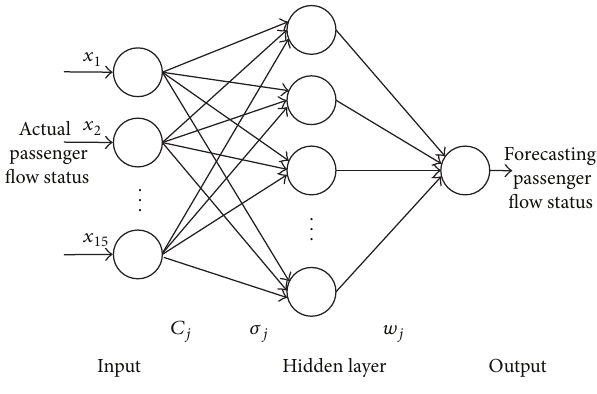
Figure 1: Structure of RBF